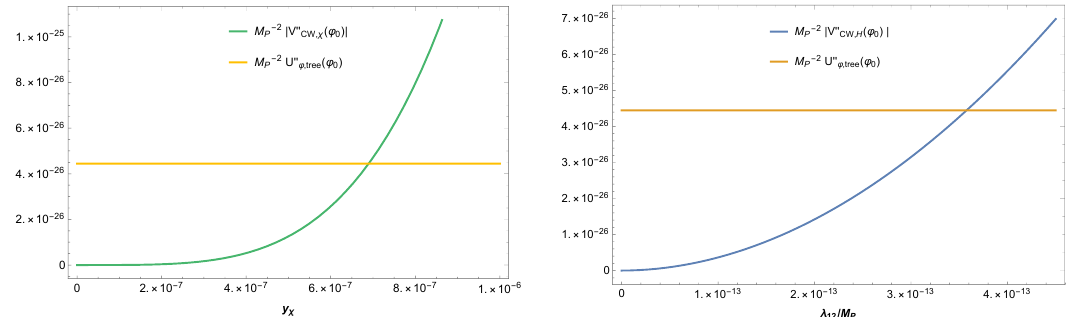
Figure 4. Allowed range for y χ and λ 12 for Model II inflation from stability analysis of the inflaton-potential. Green and blue colored line are due to CW correction for χ and H , and they are compared with tree level potential of ϕ (yellow colored horizontal